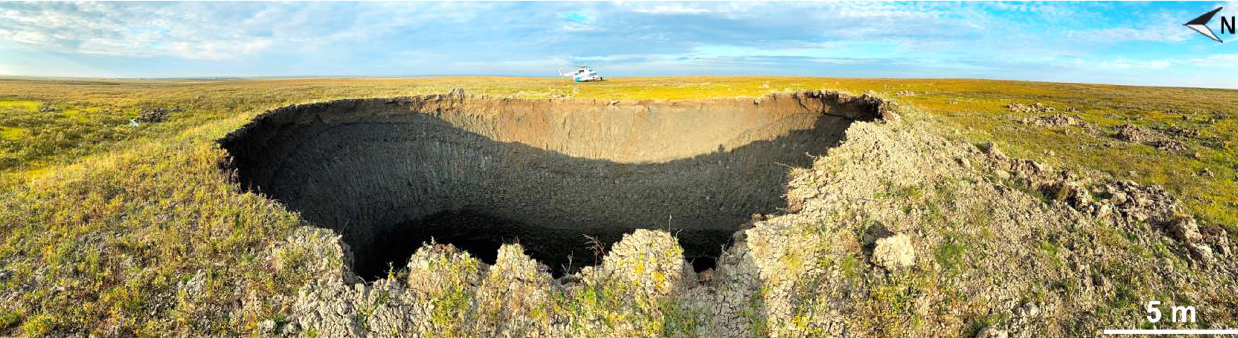
Figure 3. Panoramic photo of the C17 crater from its southern border (photo by Vasily Bogoyavlensky, August 26, 2020).